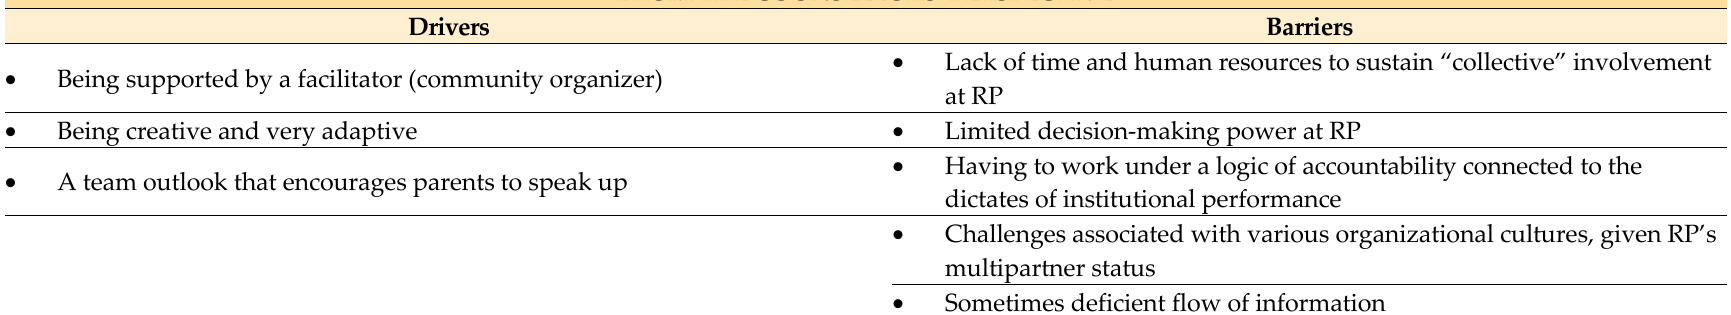
Figure 2. What are the drivers of and barriers to parents’ participation at RP?